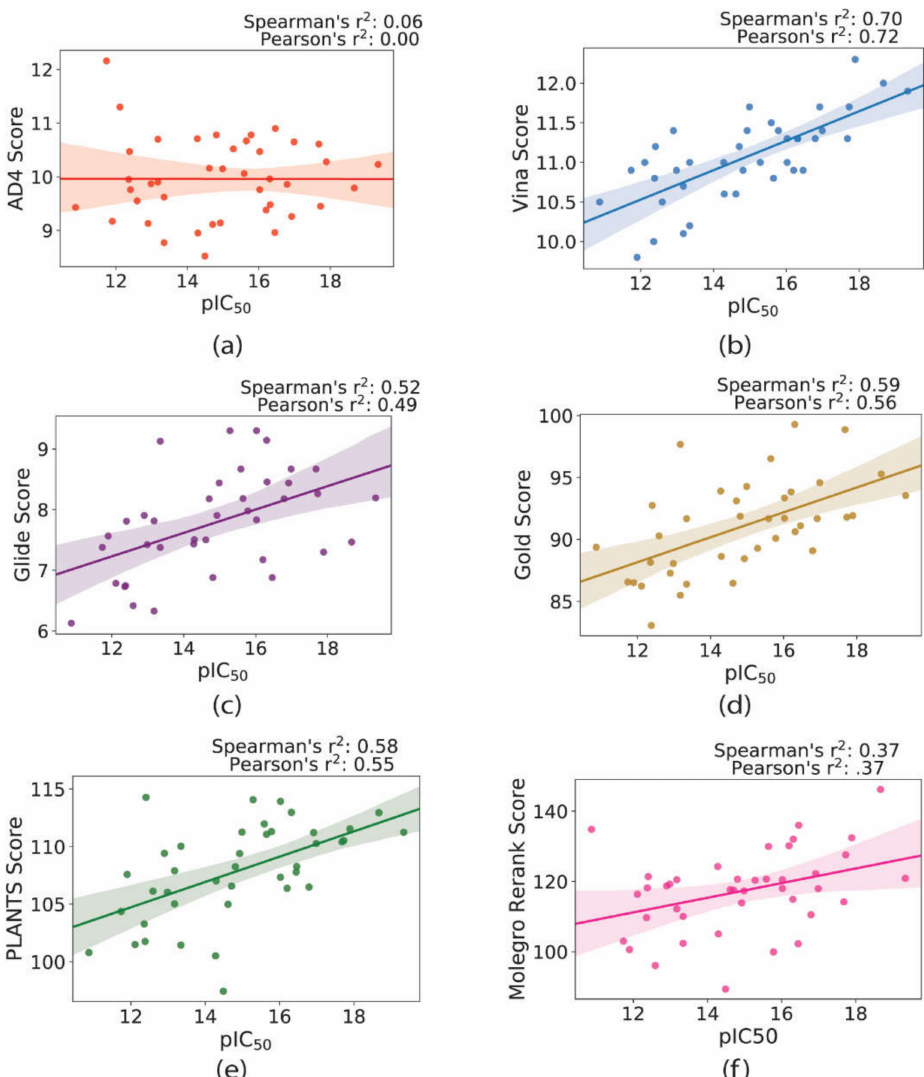
Figure6. Summaryofthecorrelationbetweenexperimentala ffi nities(pIC 50 )forcompoundsscreenedby Deaton et al. compared to the docking score for the following programs: ( a ) AutoDock 4, ( b ) AutoDock Vina, ( c ) Glide, ( d ) Gold, ( e ) PLANTS, and ( f ) Molegro. The absolute value of the docking scores was taken to produce a positive trendline. The confidence interval for the regression estimate is shown as a translucent area centered around the line of best